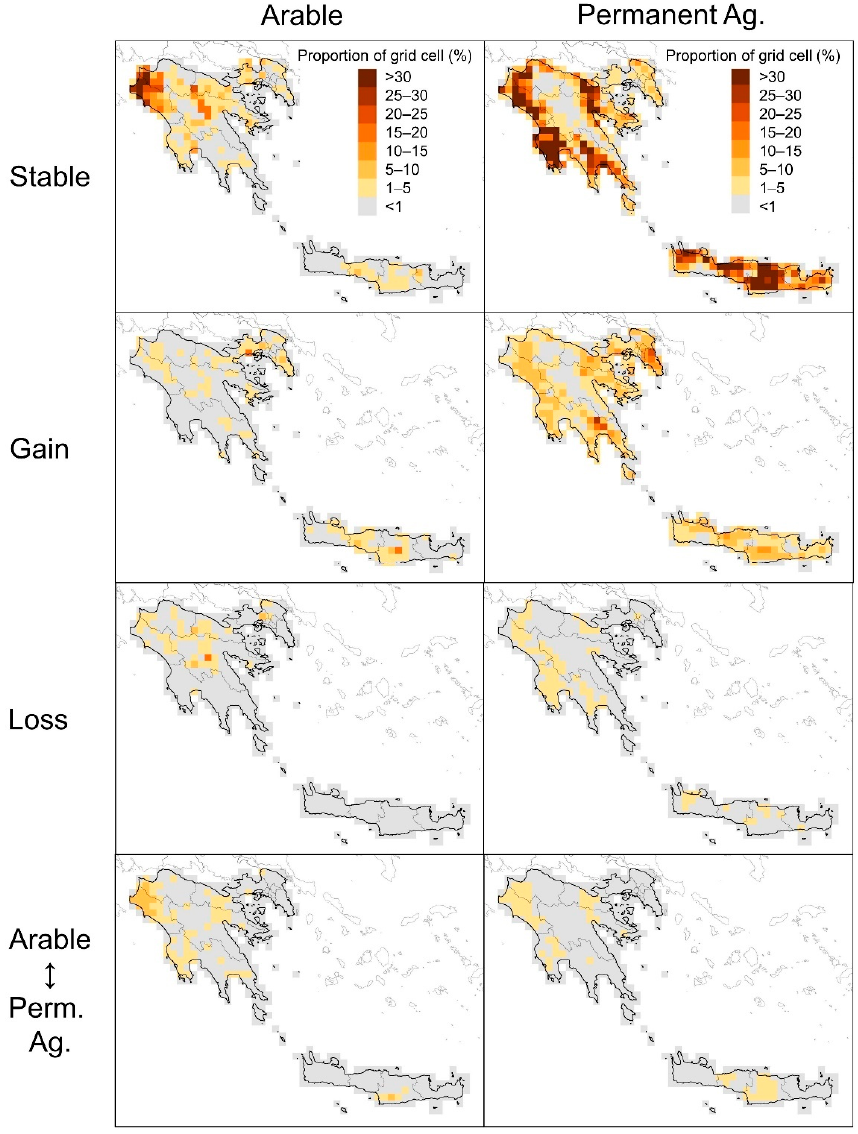
Figure 7. Arable land and permanent agriculture stable and change strata extent from 1986 to 2020. The map shows proportion of stable and change classes within 10 × 10 km grid cells. For data visualization purposes, we applied a three-year majority filter to the beginning and ending years to reduce the effects of annual crop rotation.